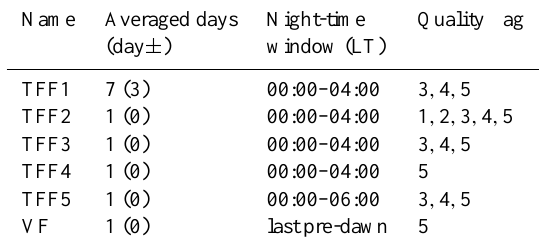
Table 1. Description of the parameters used for each one of the test foundation fields (TFF) and the validation field (VF).